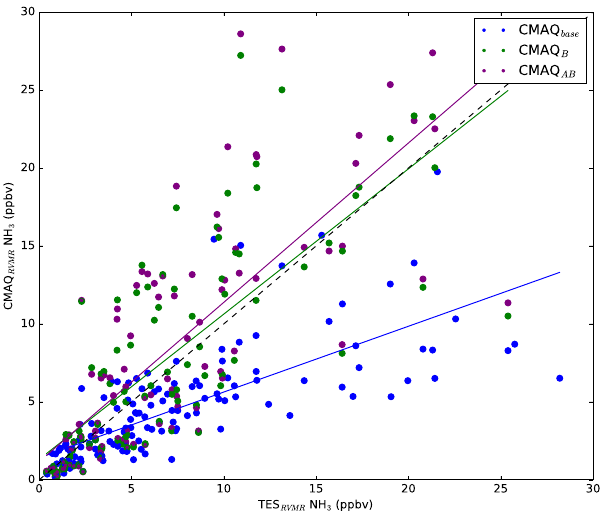
Figure 9. Box plots of (a) TES NH 3 retrieval by pressure level, (b) TES NH 3 retrieval averaging kernel (AK) diagonal, (c) dif- ference between the TES NH 3 retrieval and CMAQ base modeled NH 3 interpolated to TES levels with an AK applied for the baseline model run and (d) same as (c) but for the CMAQ AB run. Box plots show the mean (green), median (red), interquartile range (IQR, blue box), whiskers at 1.5 IQR and outliers beyond